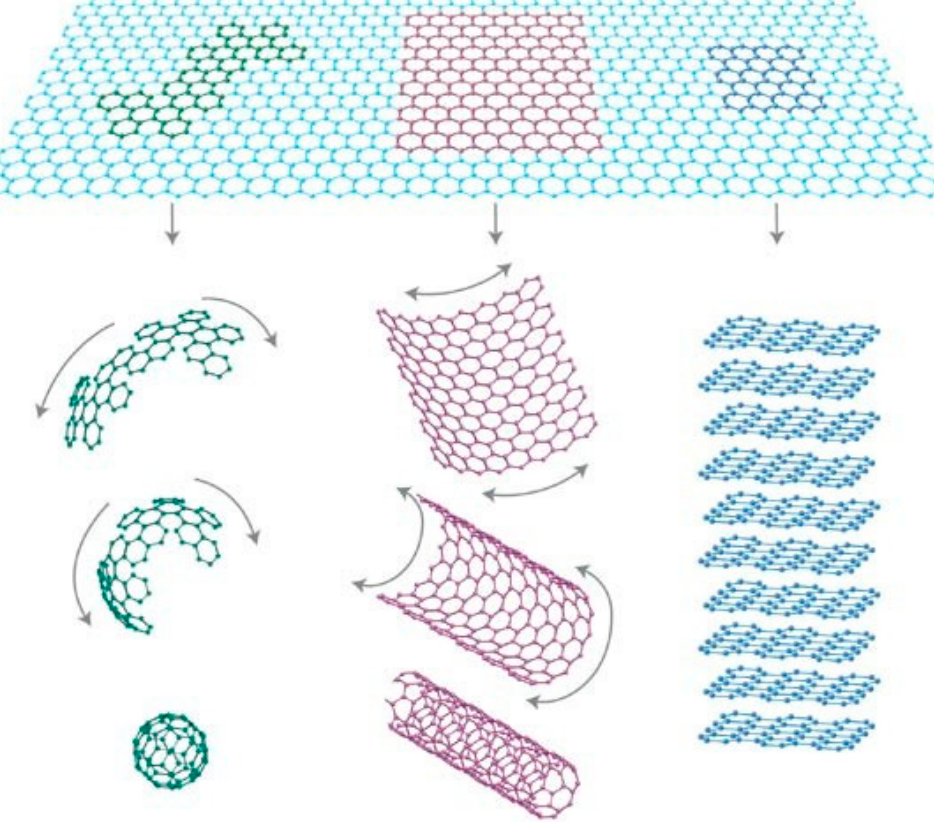
Figure 1. Graphene is a 2D material that acts as a building block for carbonaceous materials of all other dimensions. (Reproduced with permission from Ref. [3]).